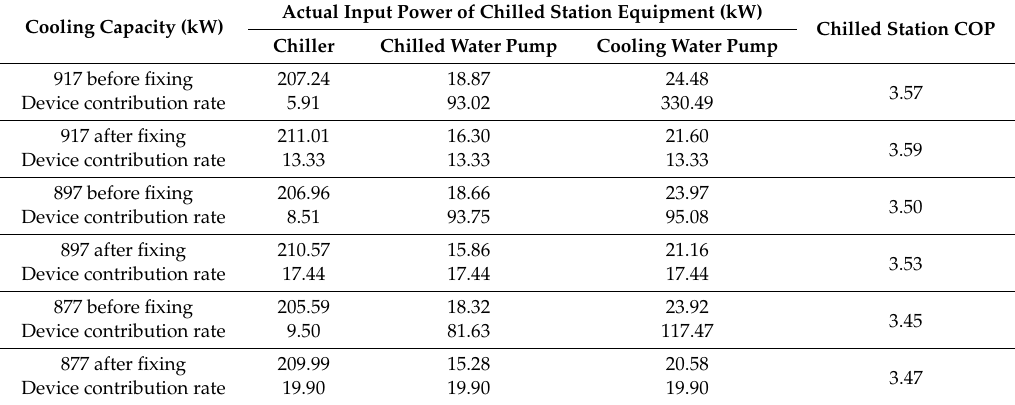
Table 9. Device contribution rate under different cooling